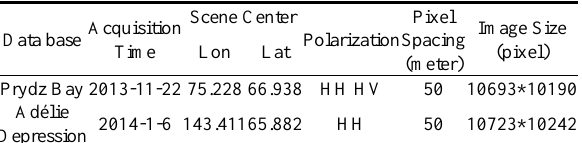
(b) Adélie Depression Figure 2. The HH channel SAR imagery and manually selected ground-truth in Prydz Bay and Adélie Depression Table II. Experimental data